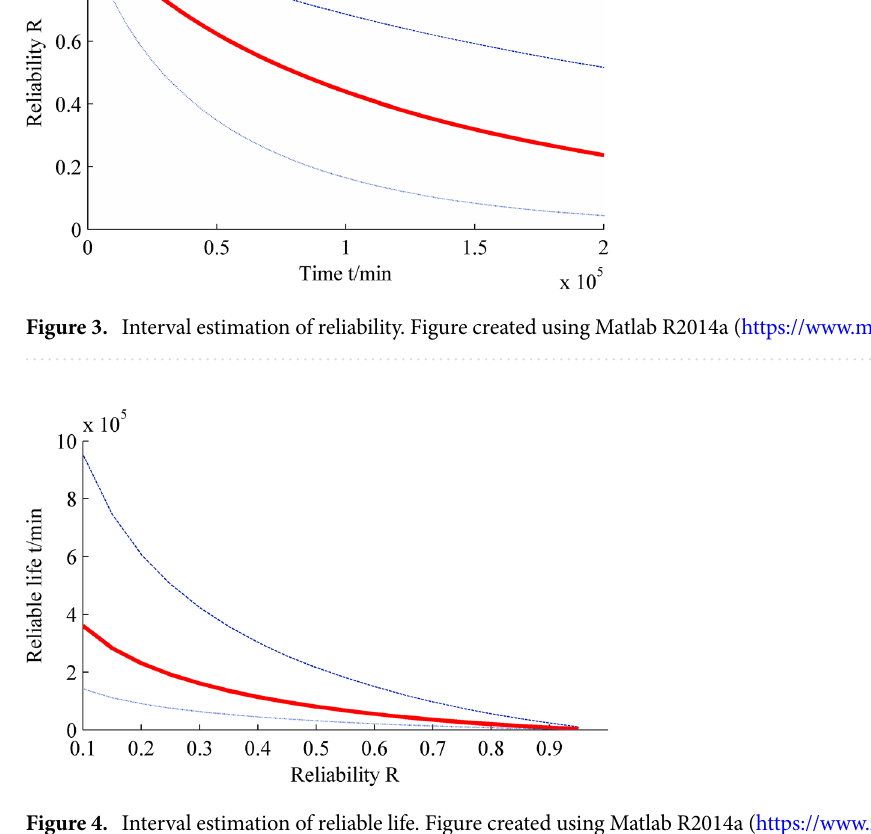
Figure 4. Interval estimation of reliable life. Figure created using Matlab R2014a (https:// www. mathw orks. com).